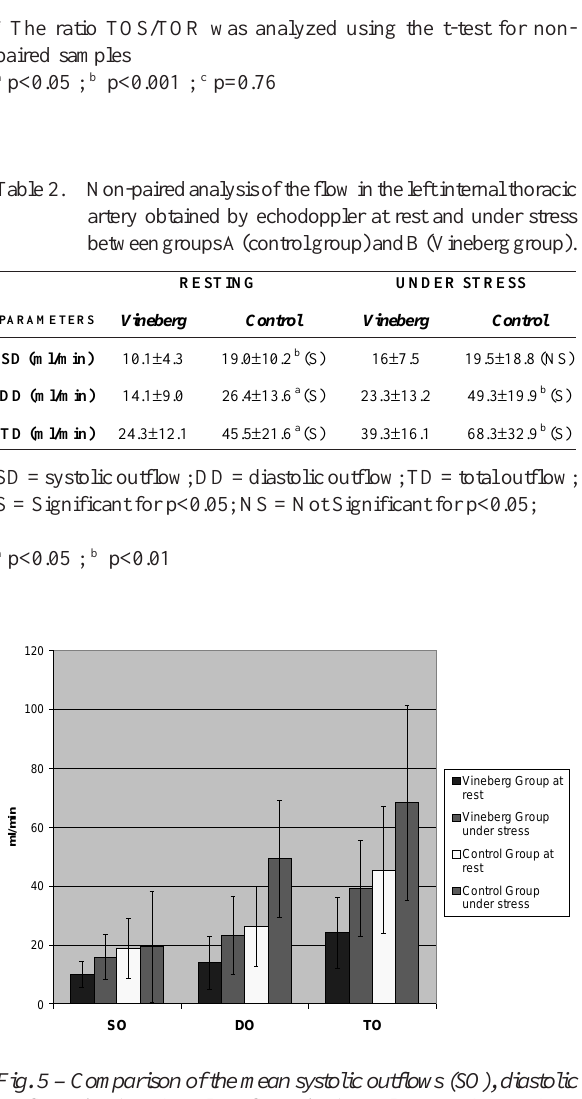
Fig. 5 – Comparison of the mean systolic outflows (SO), diastolic outflows (DO) and total outflows (TO) in ml/min in the Vineberg and control groups at rest and under